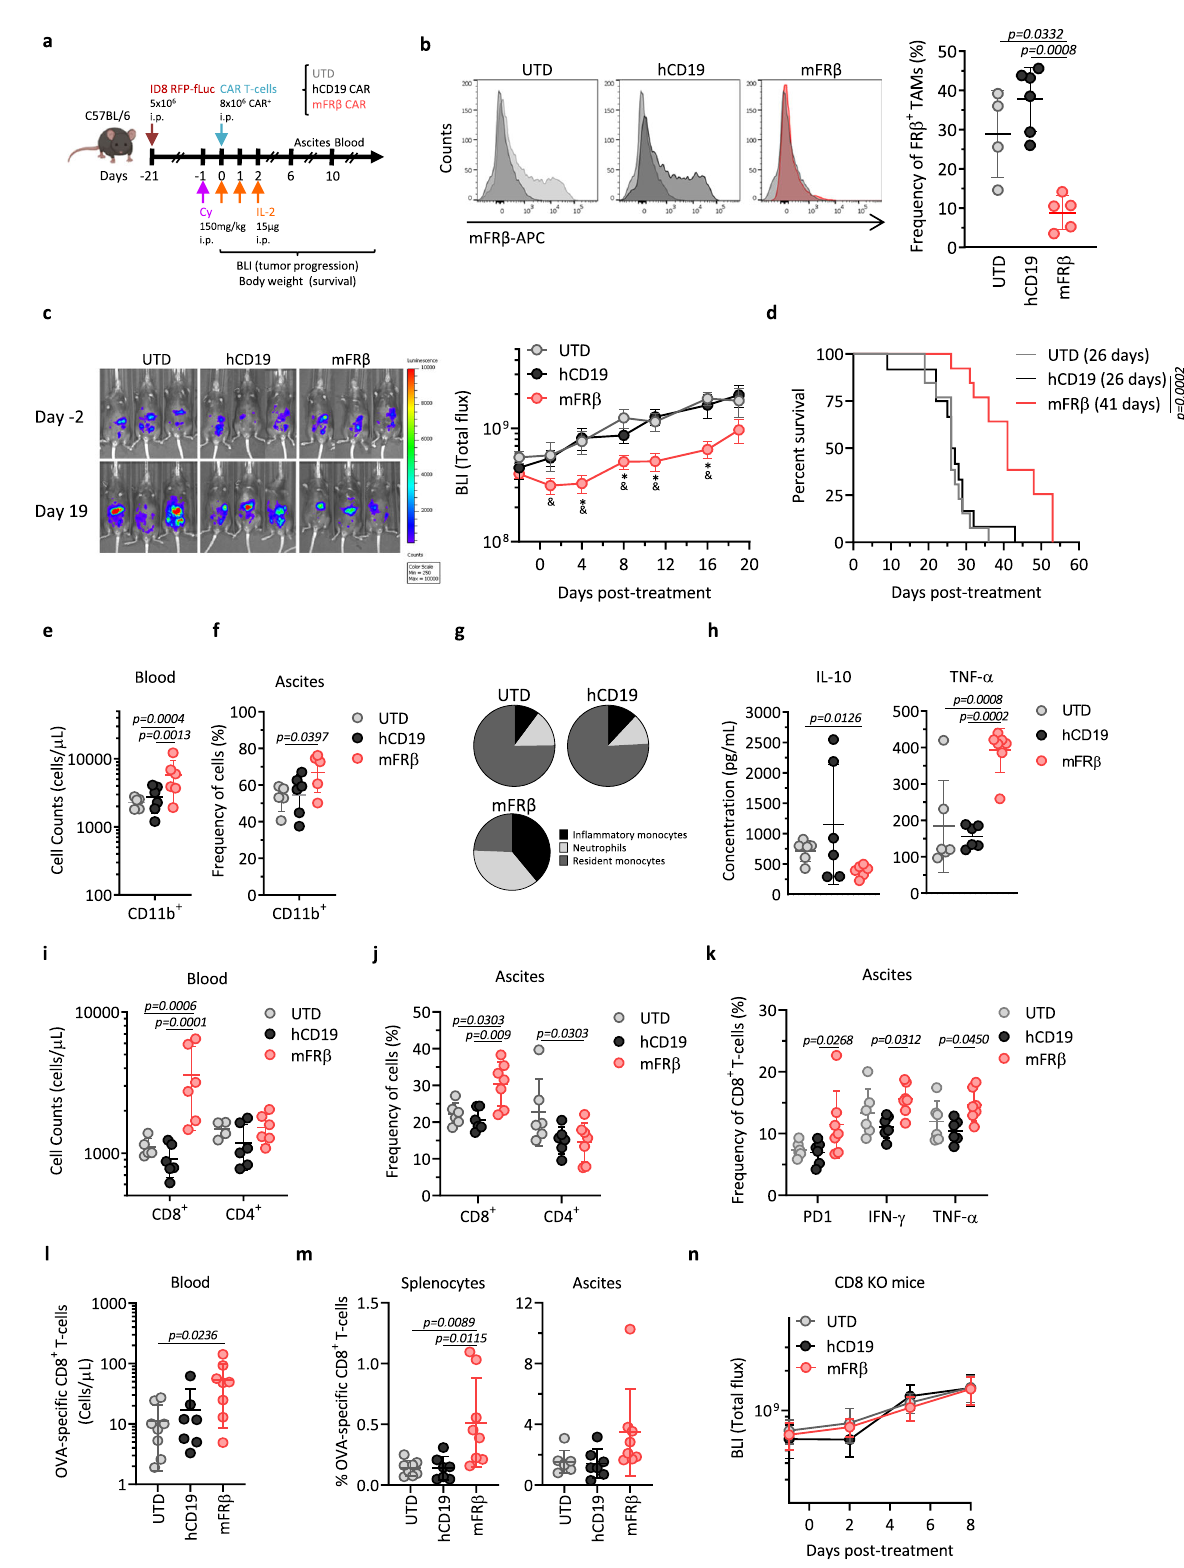
therapeutic window (Supplementary Fig. 8c). Under these con- ditions, the simultaneous combination of both CARs did not signi fi cantly improve antitumor ef fi cacy (Fig. 6b, c) or survival (Fig. 6e) over either treatment alone. By contrast, mice that received the combined, staggered treatment regimen of